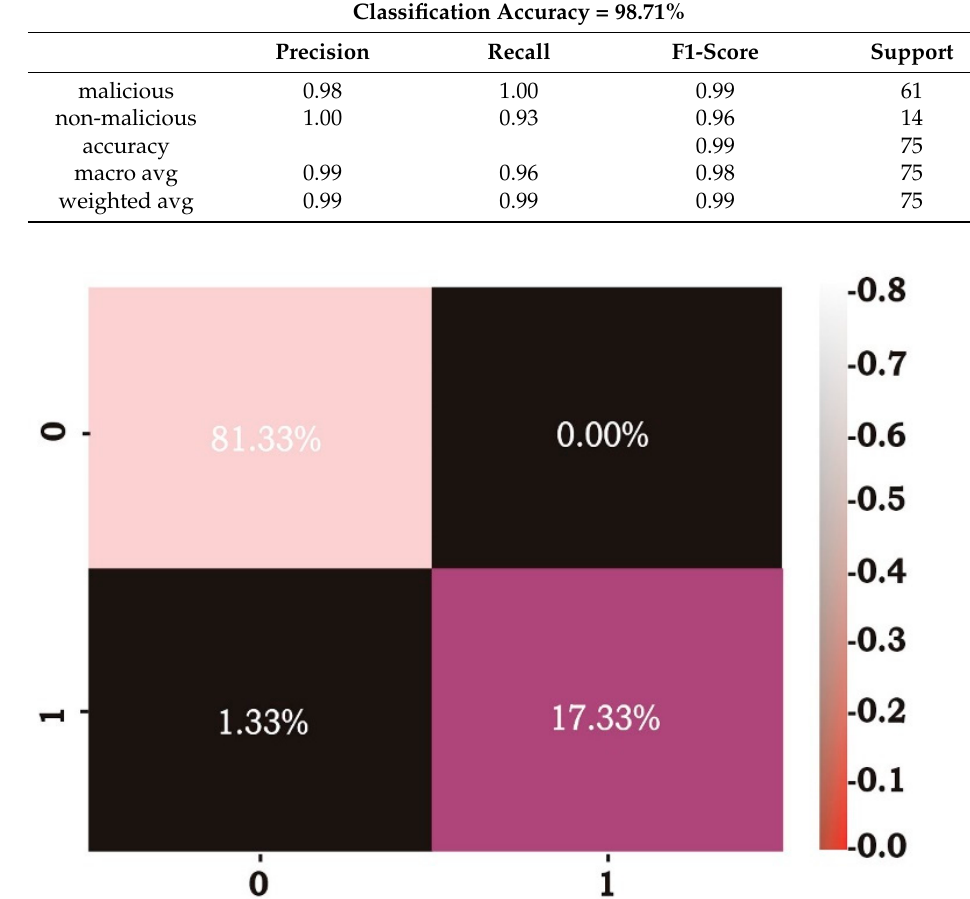
Figure A5. AdaBoost classifier model summary with a confusion matrix.